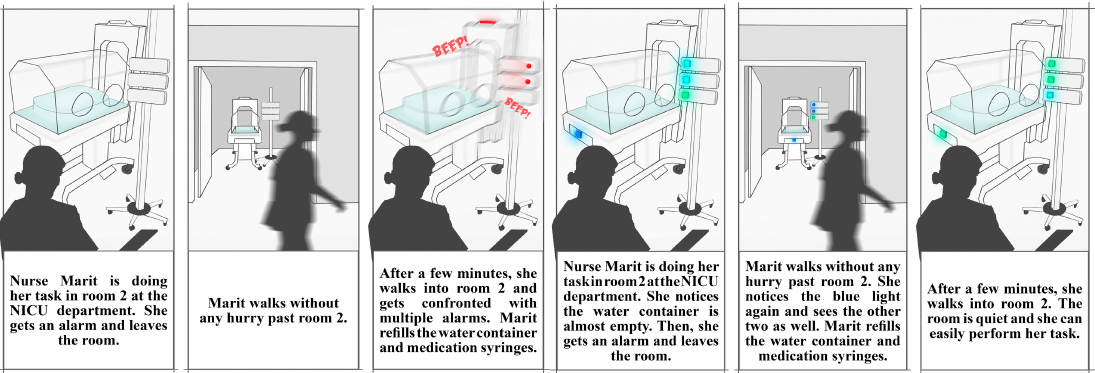
Figure 3. Sensitizing storyboard ( left ) and visionary storyboard ( right ).